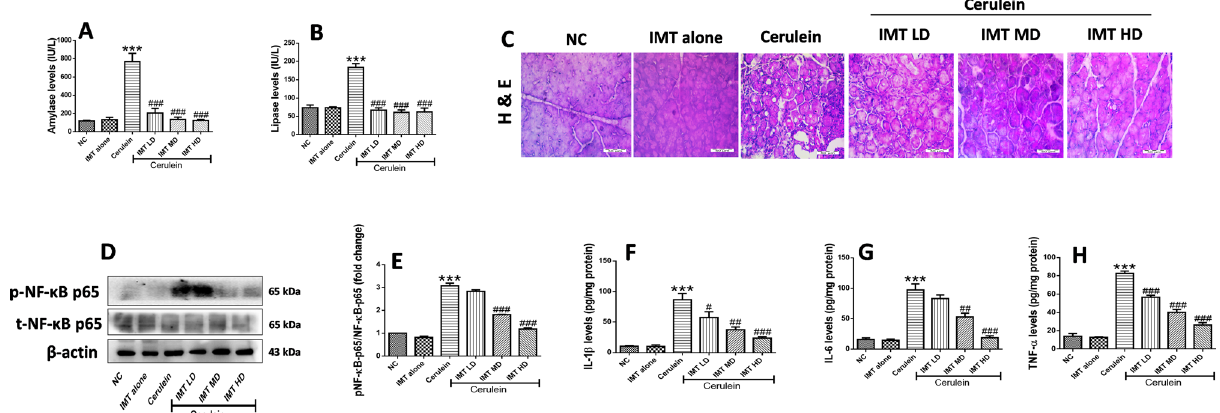
Figure 5. Effect of IMT on cerulein-induced pancreatic injury and inflammation. ( A,B ) Plasma amylase and lipase levels. ( C ) Representative photographs of H & E staining of pancreas at 400X magnification. ( D,E ) Western blot and corresponding densitometric analysis of protein expression of total and phosphorylated NF-κB in pancreas, ( F–H ) Pancreatic IL-1β, IL-6 and TNF-α levels studied by ELSA. β-actin was used as loading control. All values are represented as mean ± SEM (n = 7). Statistical significance was established using one- way ANOVA followed by Tukey’s multiple comparisons test where ***P < 0.001 vs Normal control, #P < 0.05,